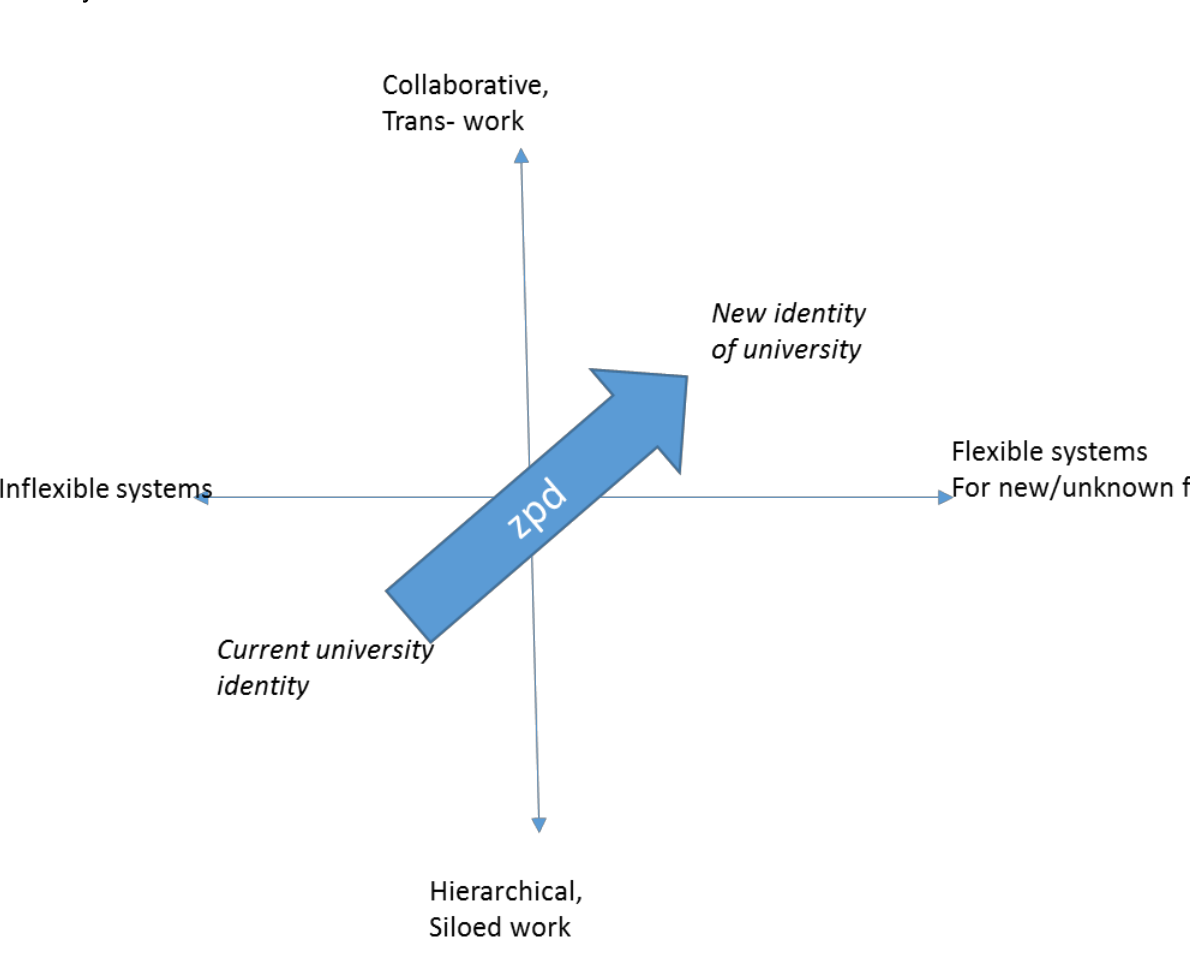
Figure 6: ZPD for a new vision for the identity of a University of